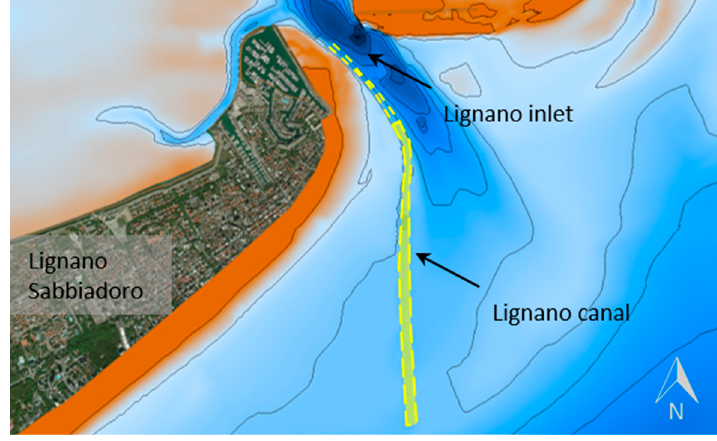
Figure 8. Position and shape of the Lignano canal.